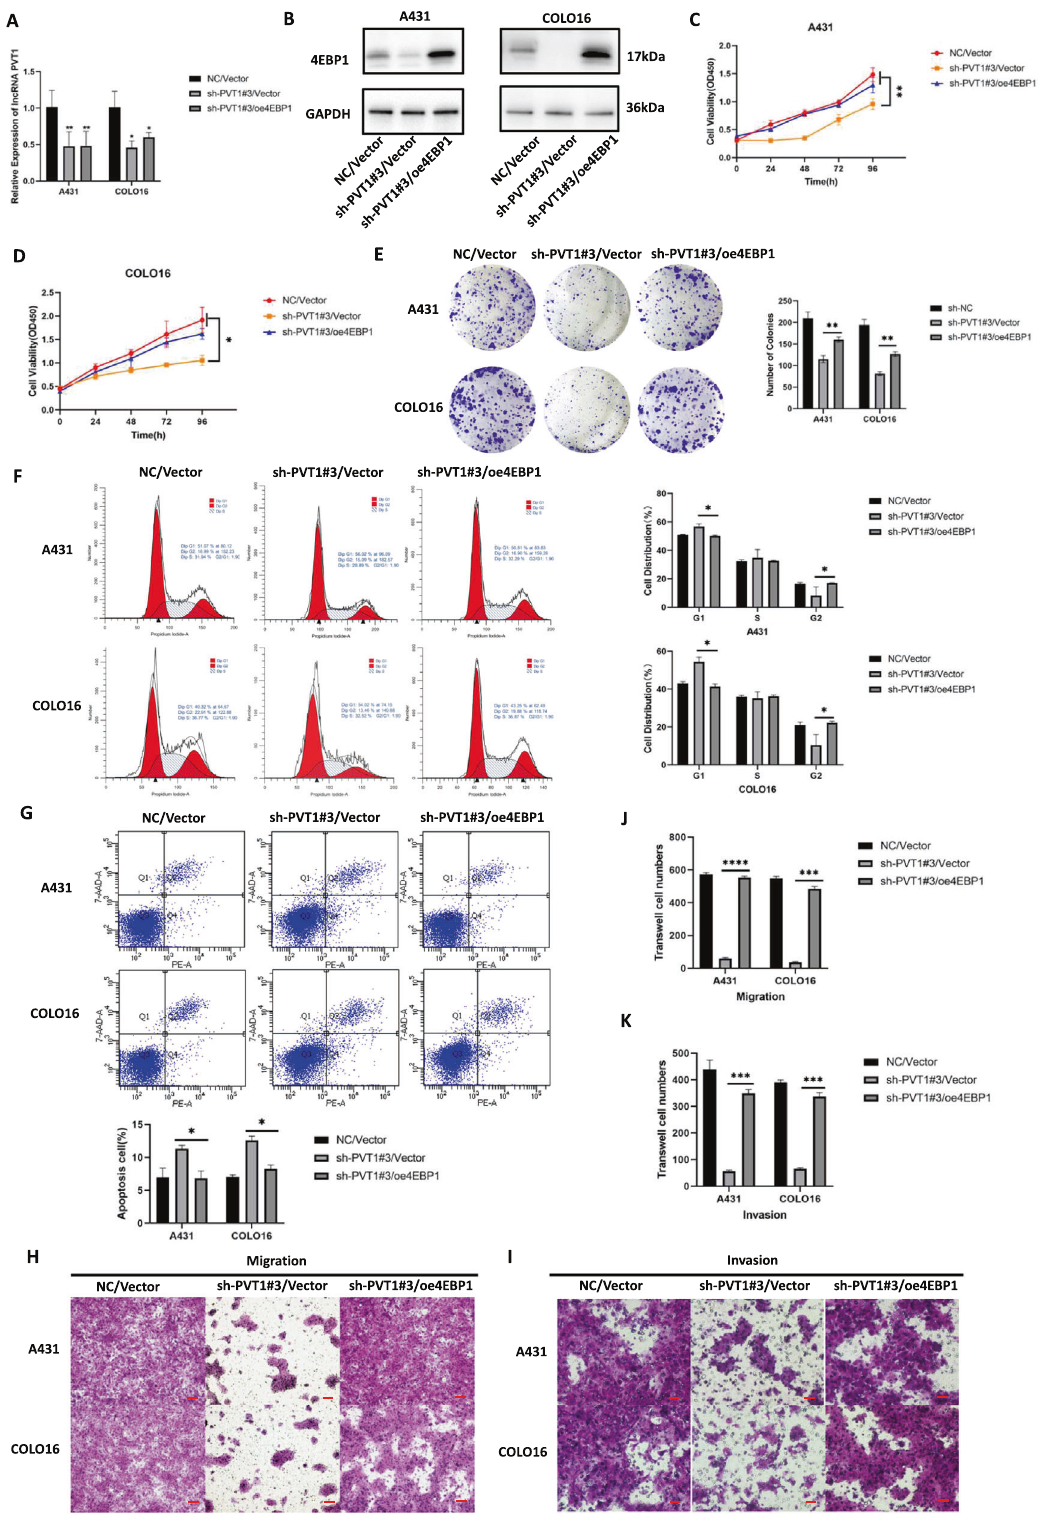
Fig. 7 4EBP1 overexpression reverses the effects of lncRNA PVT1 knockdown in A431 and COLO16 cells. A Expression of the lncRNA PVT1 as measured by RT-qPCR in stable PVT1-knockdown A431 and COLO16 cells co-transfected with 4EBP1-overexpression constructs. B Overexpression of 4EBP1 validated by WB in PVT1-knockdown A431 and COLO16 cells. C – K Knockdown of PVT1 inhibits cell proliferation, metastasis, and invasion and promotes apoptosis in A431 and COLO16 cells, but knockdown of PVT1 combined with 4EBP1 overexpression reverses this effect. Images of migrated and invaded cells by transwell assays in vitro are exhibited (×200 magni fi cation, scale bar = 50 µm). * P < 0.05, ** P < 0.01, *** P < 0.001, **** P <